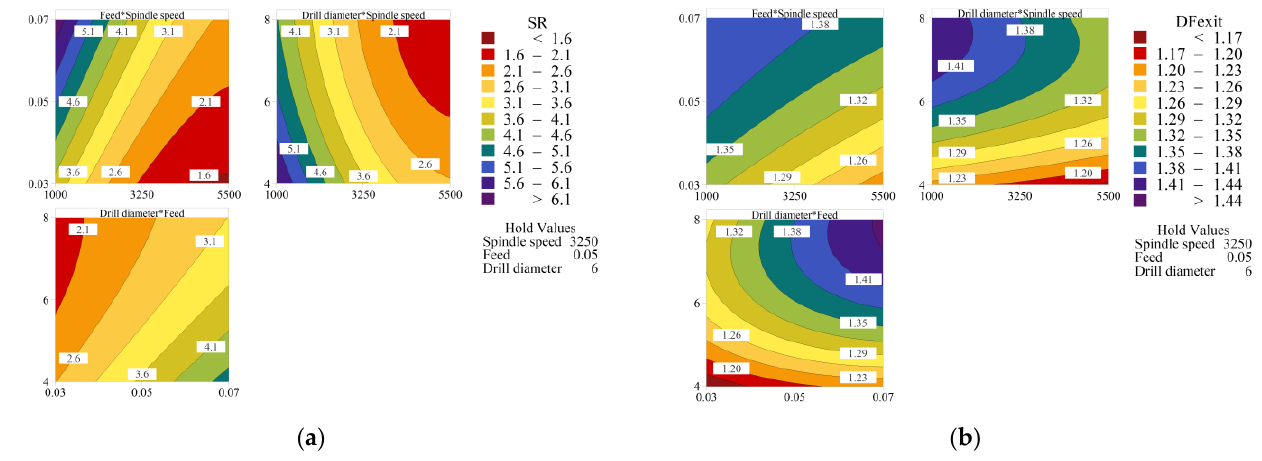
Figure 14. Contour plot of neat CEC ( a ) surface roughness and ( b ) delamination.